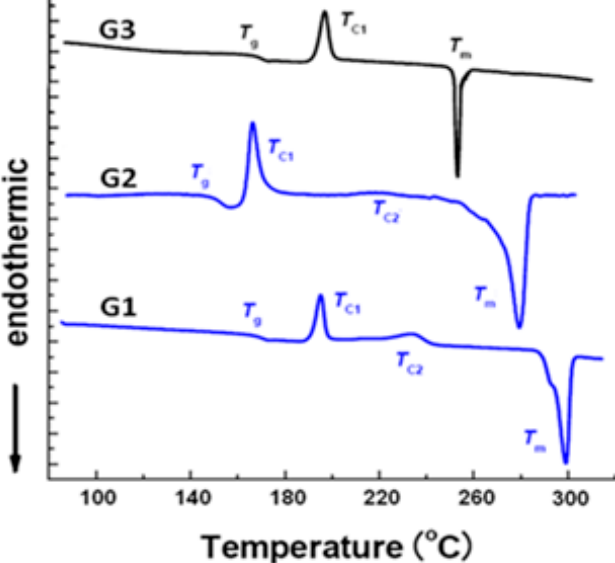
Figure 7. DSC traces of the second heating for compounds G1 , G2 and G3 . All measurements were carried out with heating rate of 10 °C/min.